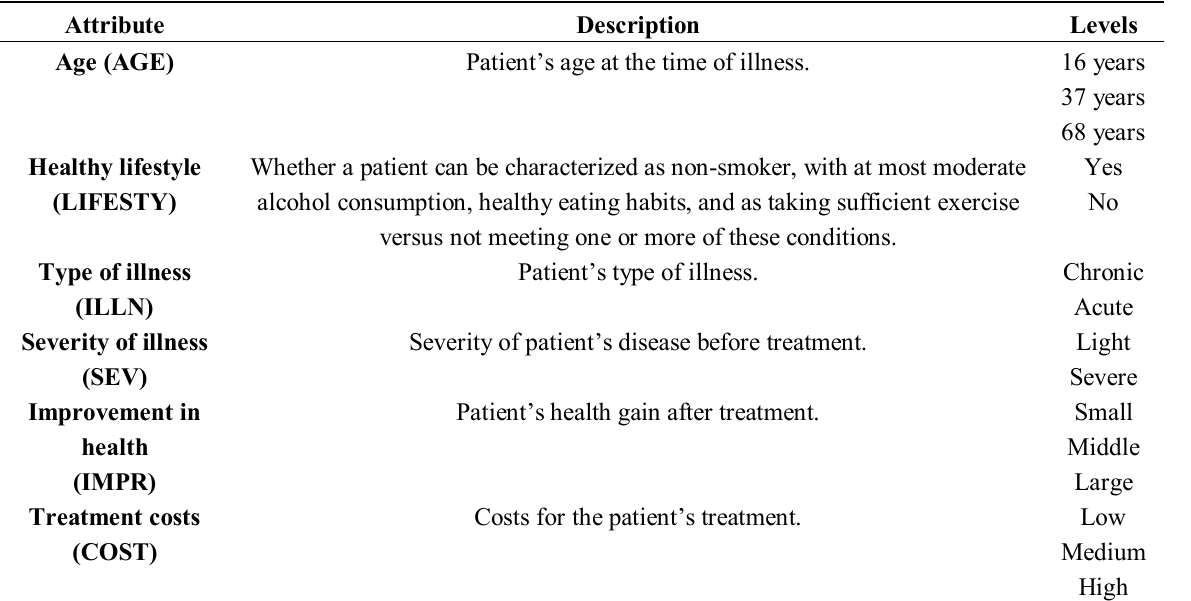
Table 2. Attributes and levels included in the Conjoint